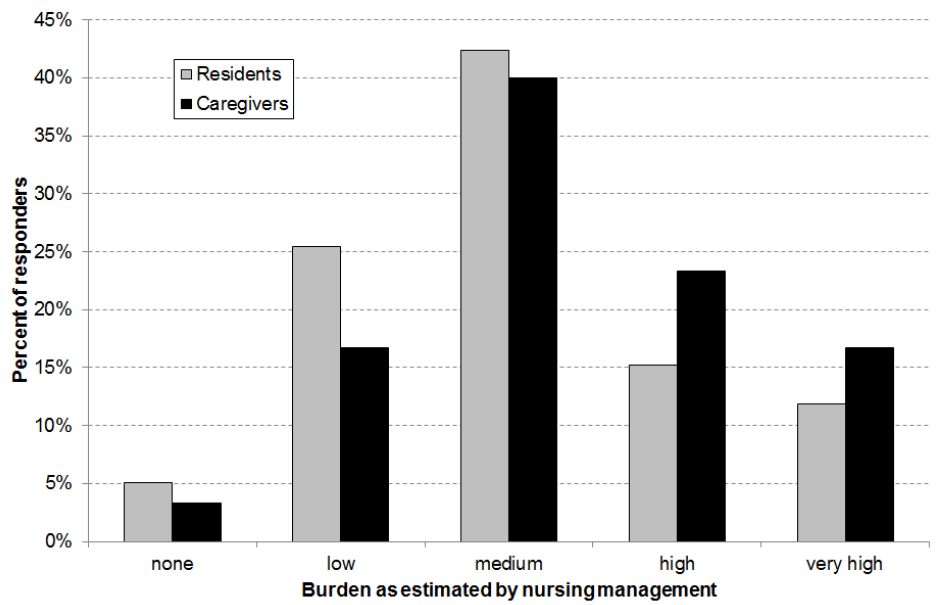
Figure 3. Burden related to diarrhea for nursing home residents and care givers as estimated by the nursing home management (total number of answers for burden for residents of n = 59 and for burden for care givers n = 59).